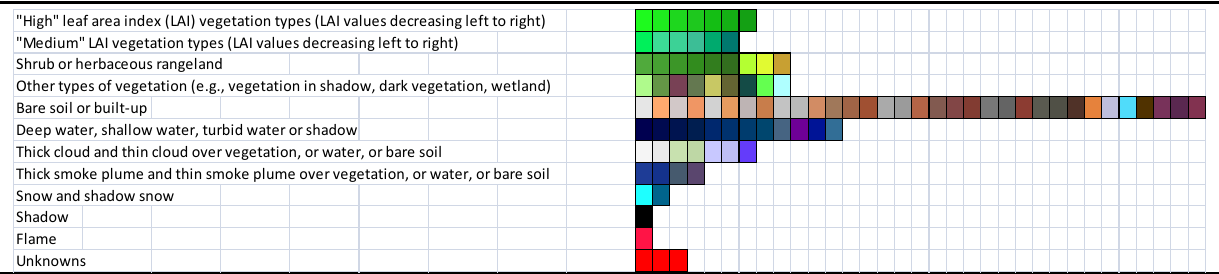
Table 2. Previously shown in [23]. Preliminary classification map legend adopted by L-SIAM™ at fine semantic granularity consisting of 95 spectral categories (refer to Table 1). Pseudo-colors of the spectral categories are grouped on the basis of their spectral end member (e.g., ‘ bare soil or built-up ’) or parent spectral category (e.g., “high” leaf area index (LAI) vegetation types). The pseudo-color of a spectral category is chosen so as to mimic natural colors of pixels belonging to that spectral category. This legend gives a clue about the semantic “parent-child” relationship supported by L-SIAM™ at different semantic granularity levels (refer to Figure 7 below). For example, a line-specific OR-combination of the 95 “child” spectral categories detected at the fine semantic granularity level across the 12 lines of Table 2 would provide 12 “parent” spectral categories at a coarser level of semantic granularity. Since it deals with symbolic reasoning, then this semantic aggregation is inherently subjective (equivocal, arbitrary, fuzzy) in nature, refer to Section 3 in [3].